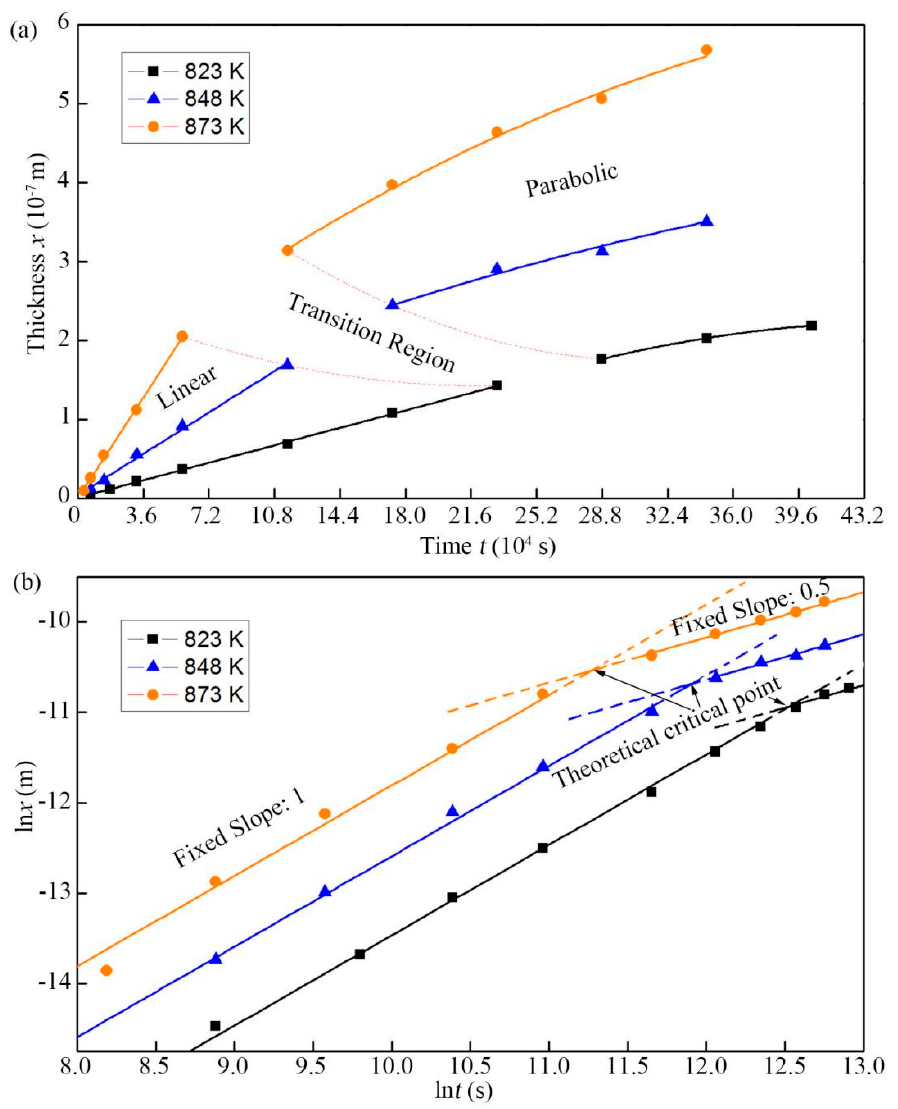
Figure 5. The average thickness of TiAl 3 layer at different experiment conditions in normal scale ( a ) and logarithmic scale ( b ).